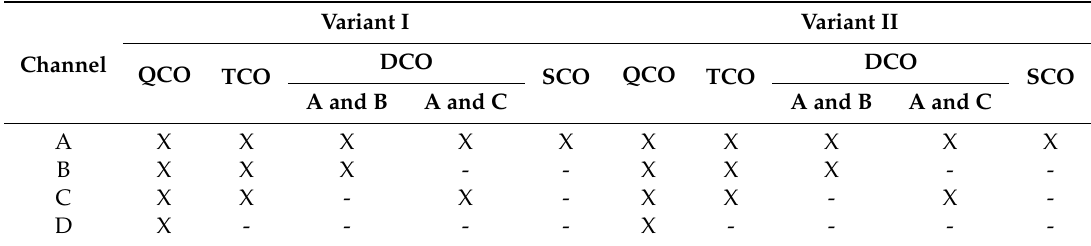
Table legend: QCO — quad-channel operation, TCO — triple-channel operation, DCO — dual- channel operation, SCO — single-channel